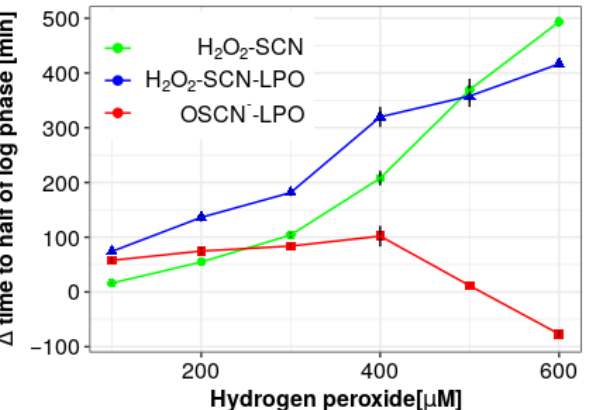
Figure 6. Green line with dots represents concentration-dependent toxicity against S. mutans by lactoperoxidase substrates (H 2 O 2 and SCN – ions) and is expressed as time difference to reach half of log phase between the sample containing substrates and sample containing S. mutans only. Similarly, blue line with triangles represents the toxicity dependent on substrates and products of lactoperoxidase system generated in situ. Red line with squares is the difference between the whole LPO system toxicity and substrates-only toxicity, which corresponds to the toxicity dependent on the LPO products. Positive value of that parameter indicates an antimicrobial effect of the system, while negative value indicates protection against the toxicity of the substrates.